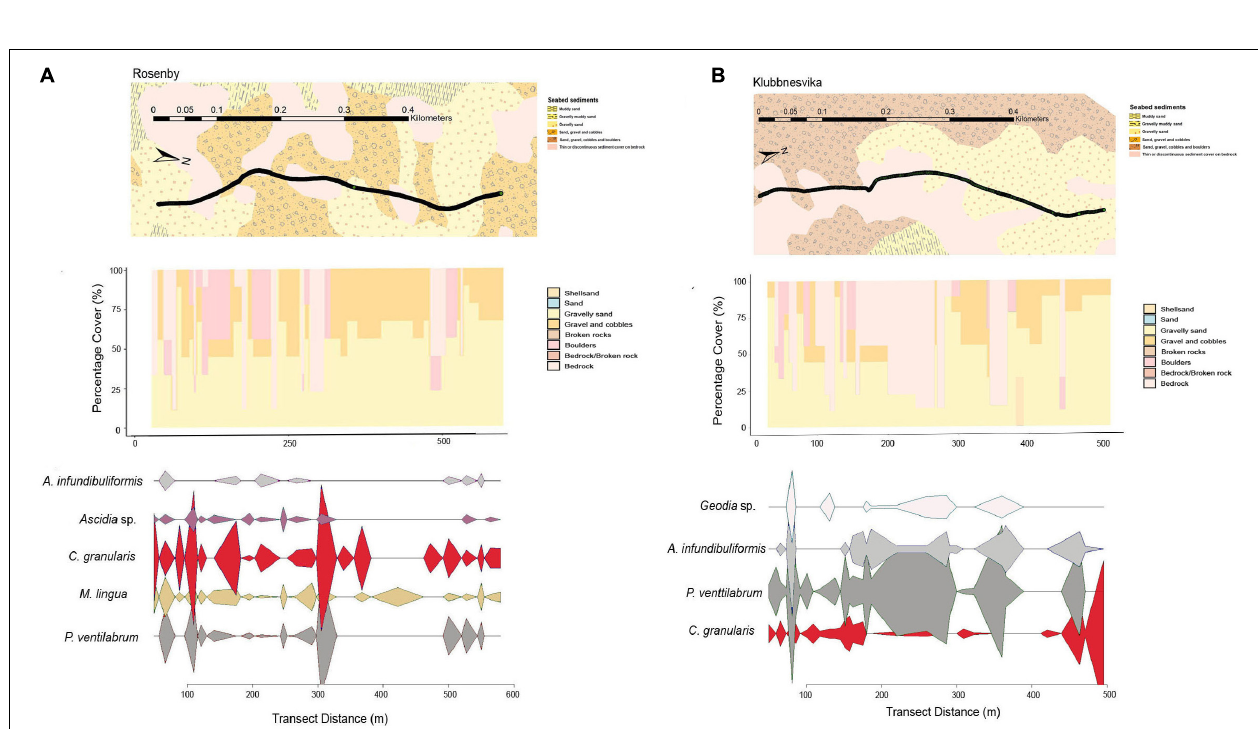
FIGURE 5 | Mixed-substrate seabed characteristics, sequential bar plots of the percentage coverage of the primary substrate types from the camera transects and densities of key epifaunal species or genus at the transect sites in (A) Rosenby and (B) Klubbnesvika.